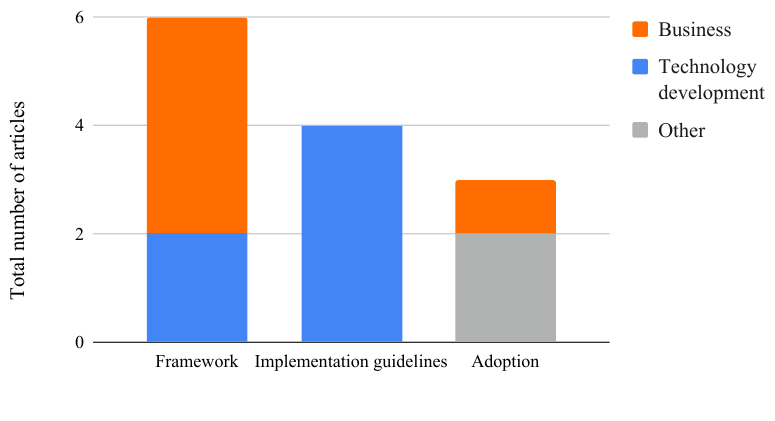
Figure 7. A portion of presentation of blockchain research in